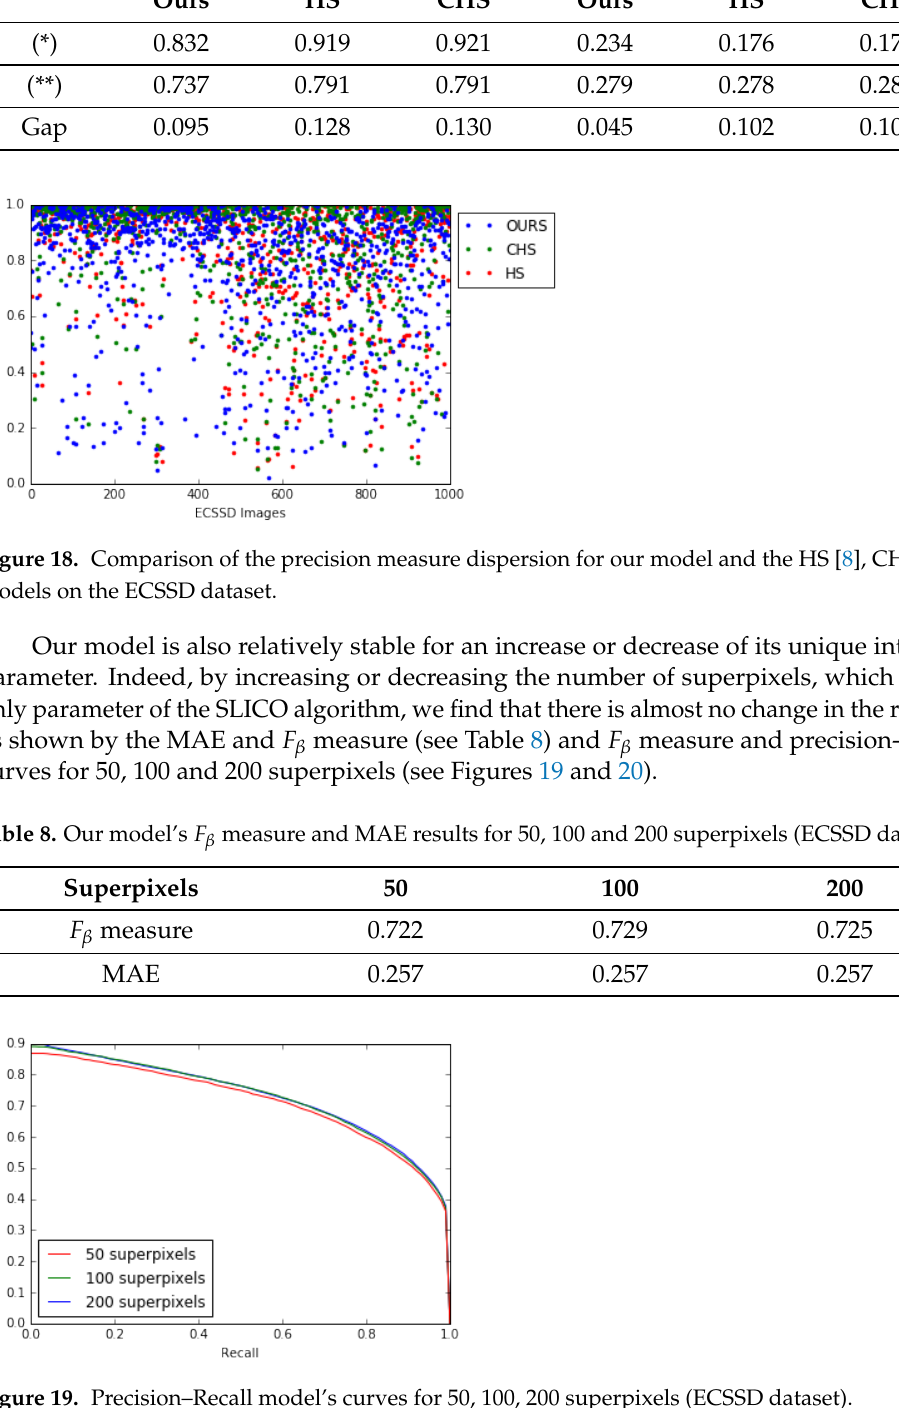
Figure 19. Precision–Recall model’s curves for 50, 100, 200 superpixels (ECSSD